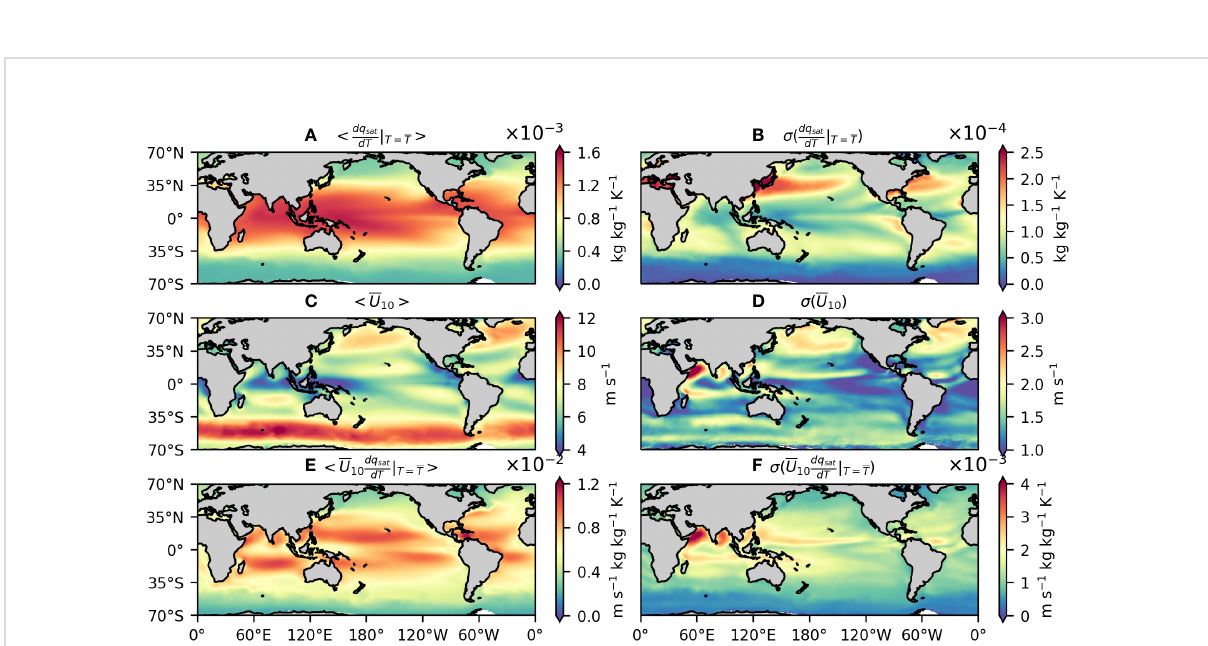
FIGURE 6 Time-mean (A) dq sat dT j T = (cid:1) T , (C) (cid:1) U 10 , and (E) their product (cid:1) U 10 dq sat dT j T = (cid:1) T in the global ocean during 2008 – 2020. (B, D, F) Same as panels (A, C, E) but for the standard deviation of dq sat dT j T = (cid:1) T , (cid:1) U 10 , and (cid:1) U 10 dq sat dT j T = (cid:1) T